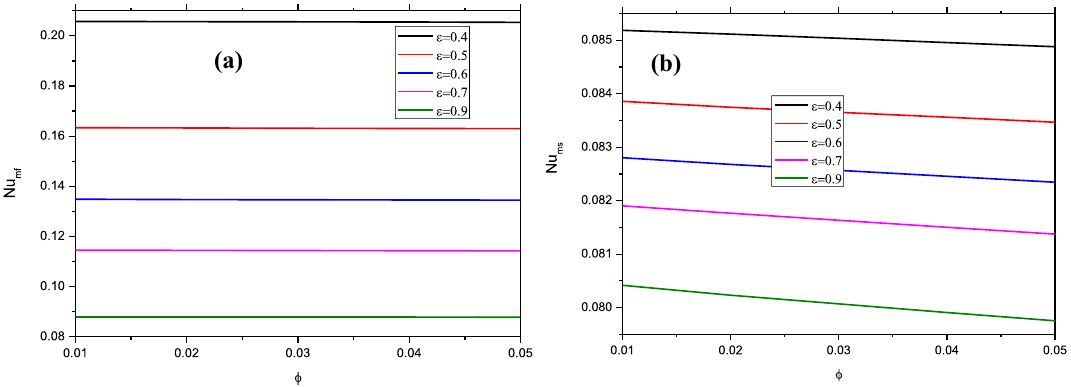
Fig. 14 Porosity parameter profiles of the average Nusselt number of fluid phase (left) and solid phase (right) for TiO Nanofluid at Ha = 10 , Q = 1 , Da = 10 – 3 , Ri = 1 , Gr